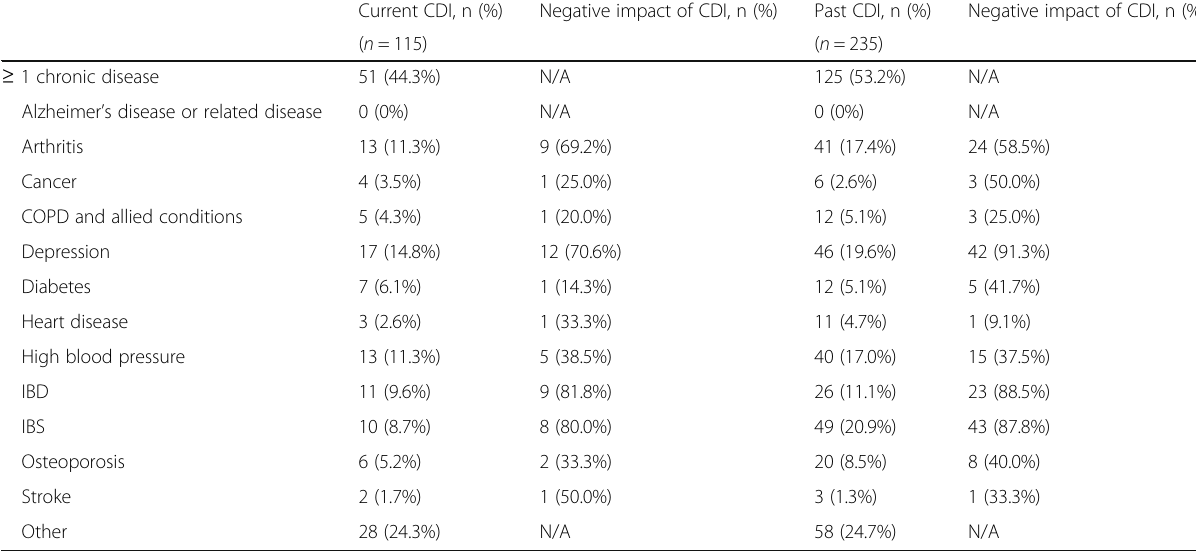
Table 3 Self-assessed impact of Clostridioides difficile infection (CDI) on participants ’ chronic